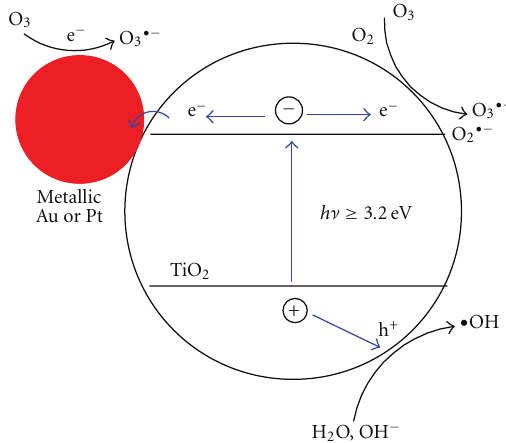
Figure 6: Proposed mechanism of enhanced electron-hole separa- tion caused by deposited noble metallic Au or Pt nanoparticles and O 3 decomposition routes on the Pt or Au modified TiO 2